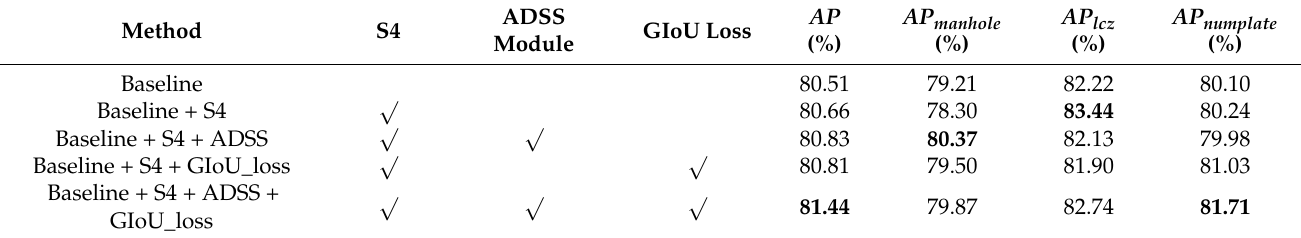
S4 is abbreviation for ResNet-50-S4. Bold indicates the best performance.